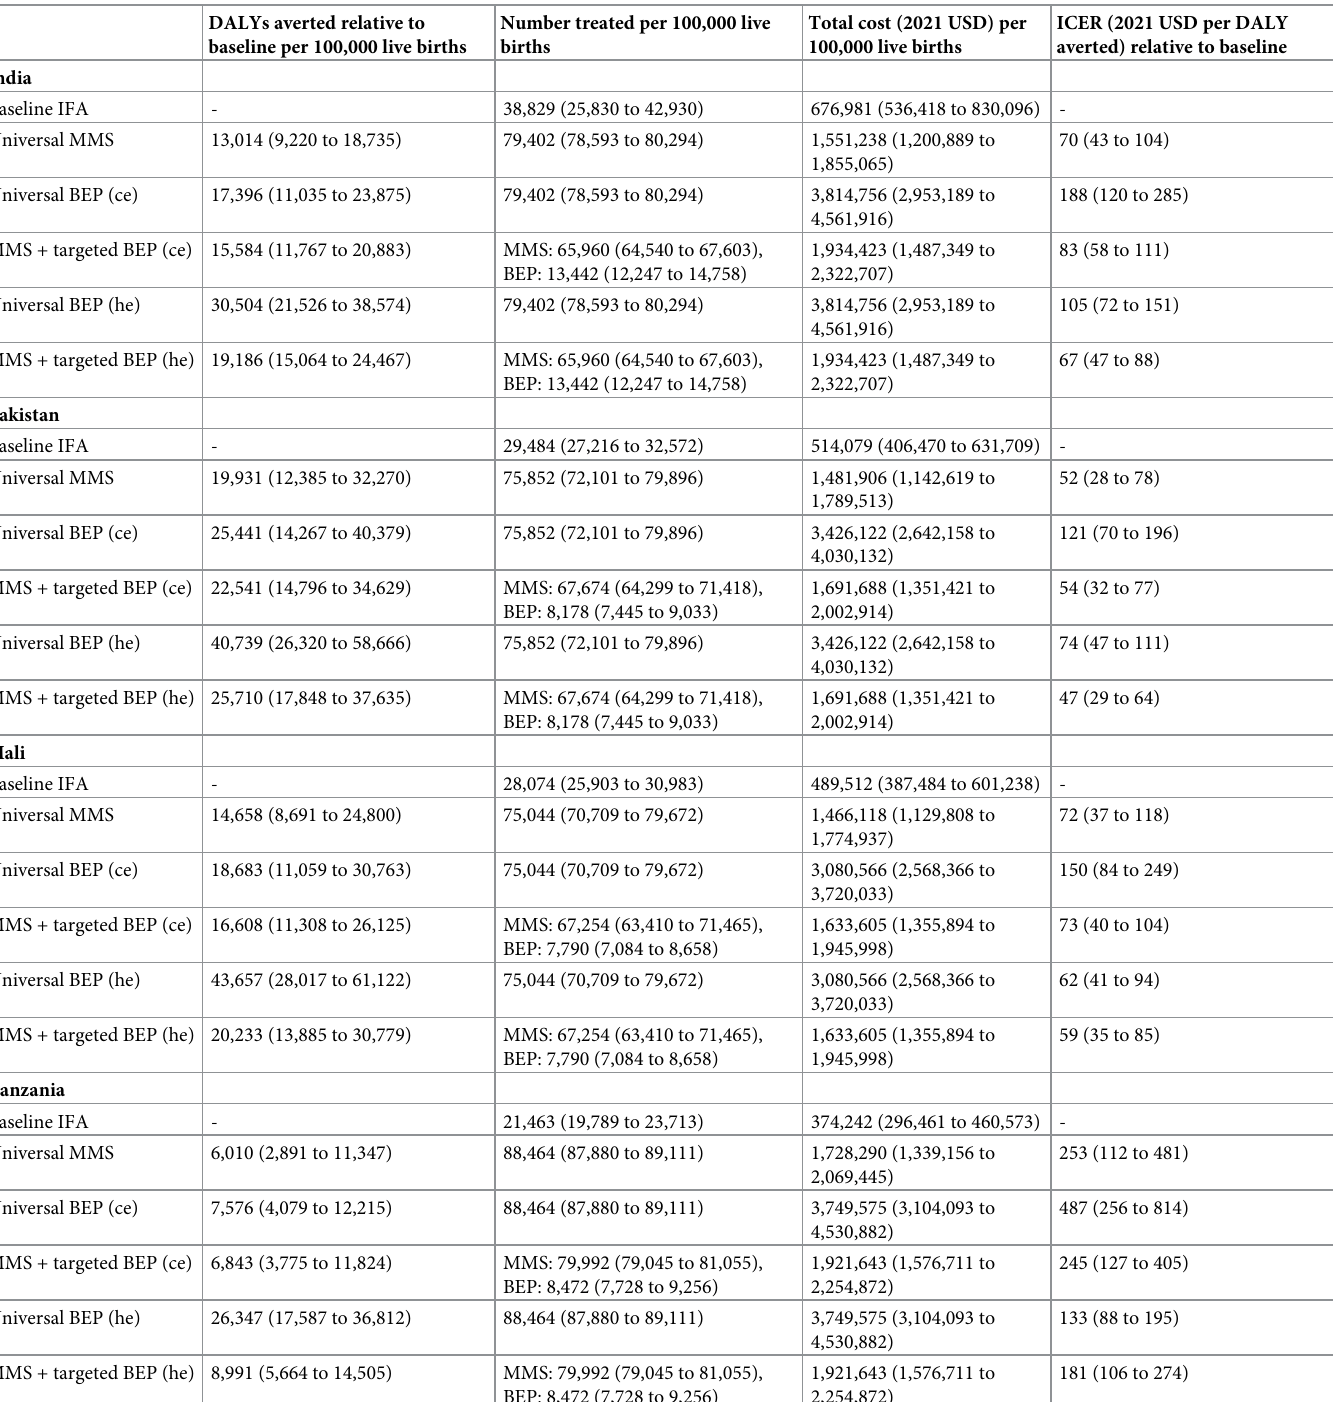
Table 5. Population-level effect and cost-effectiveness of interventions over first 2 years of life with 95% UIs. DALYs averted relative to Number treated per 100,000 live baseline per 100,000 live births